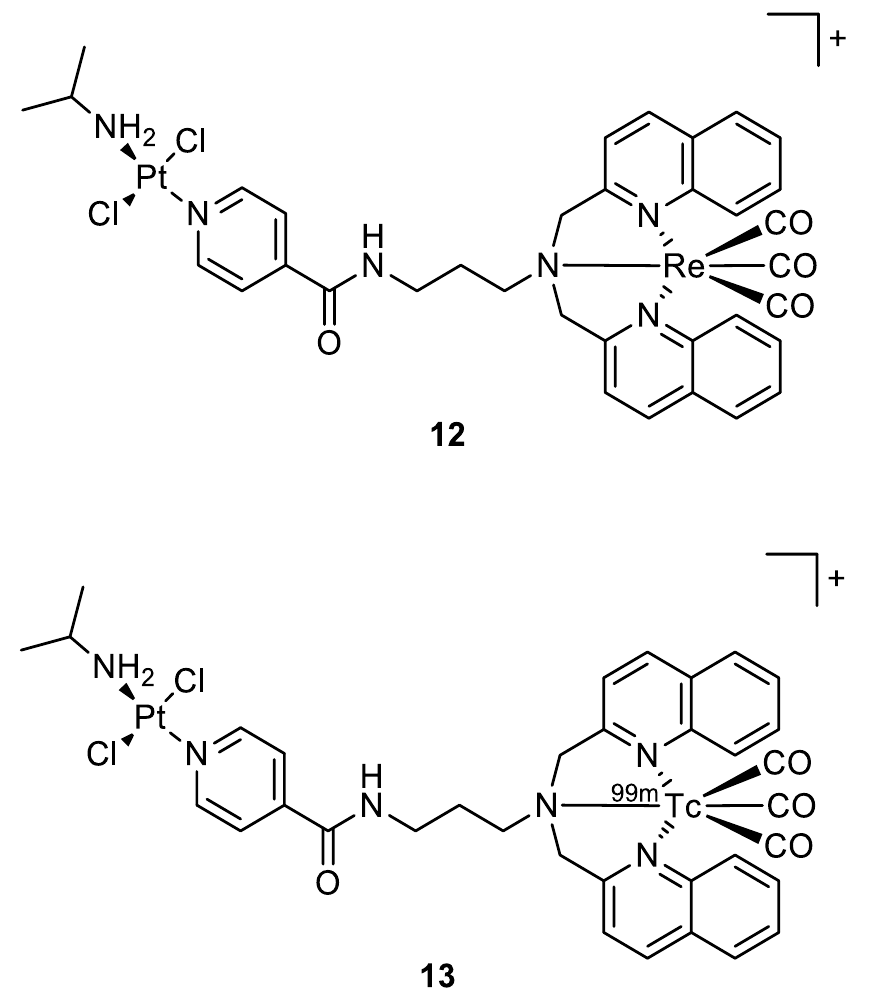
Figure 7. Molecular structure of compounds 12 and 13 .